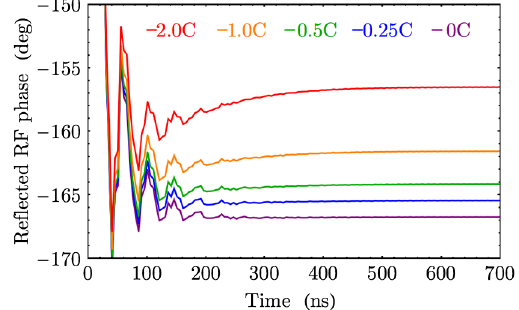
FIG. 4. Mark 1 X -band rf gun reflected power at the input port as a function of temperature change for a square input